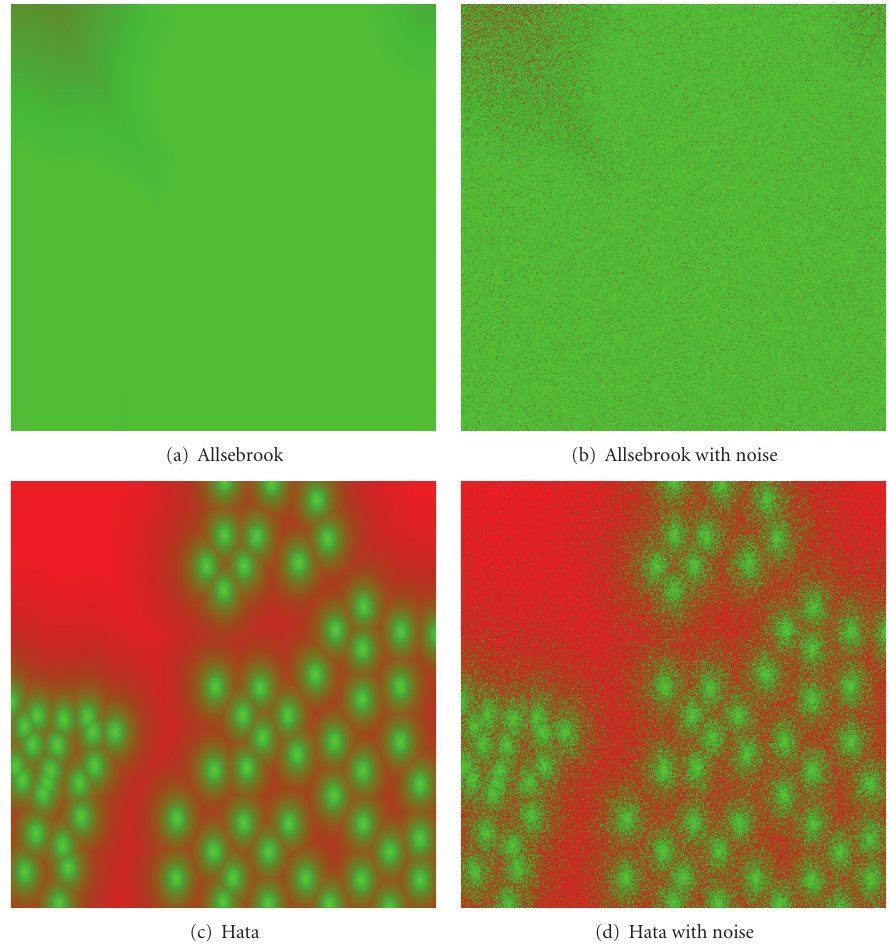
Figure 12: Comparison of predicted coverage maps for Portland, OR using two well-performing models, with and without the same scale Gaussian error included. True green indicates predicted recieved signal at − 30dBm, and true red indicates predicted recieved signal at the noise floor ( − 95dBm). Intermediary values are linearly interpolated between these two color